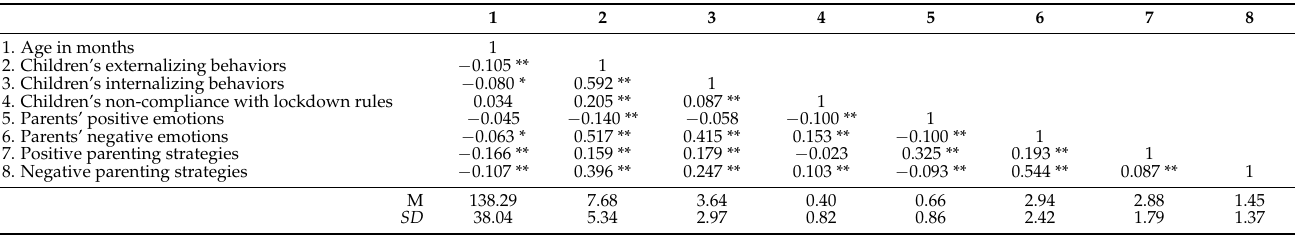
Table 1. Descriptive statistics (means and standard deviations) and correlations (after residualizing by